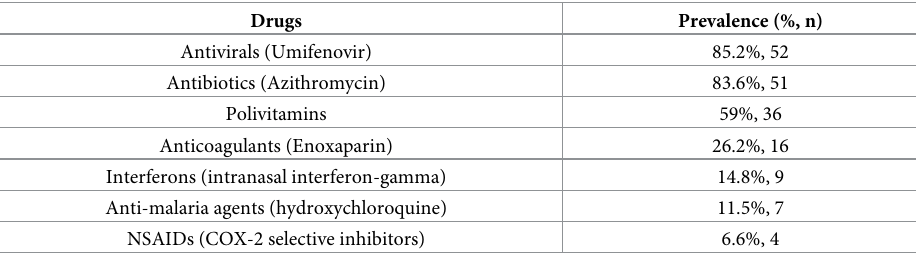
Table 2. Drugs utilized for the treatment of COVID-19 infection.